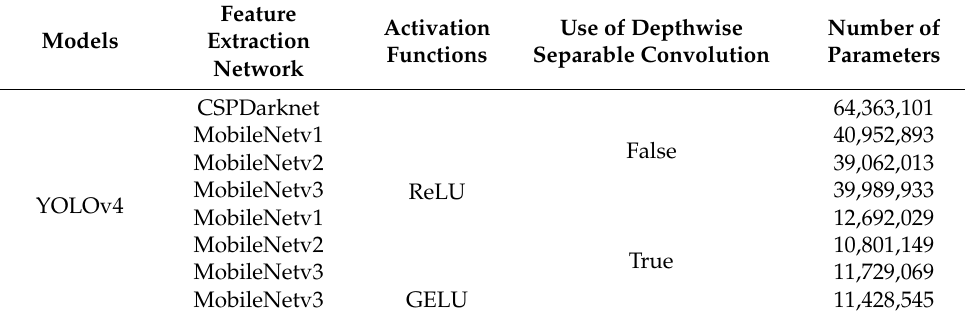
Table 1. Table of different network model parameter